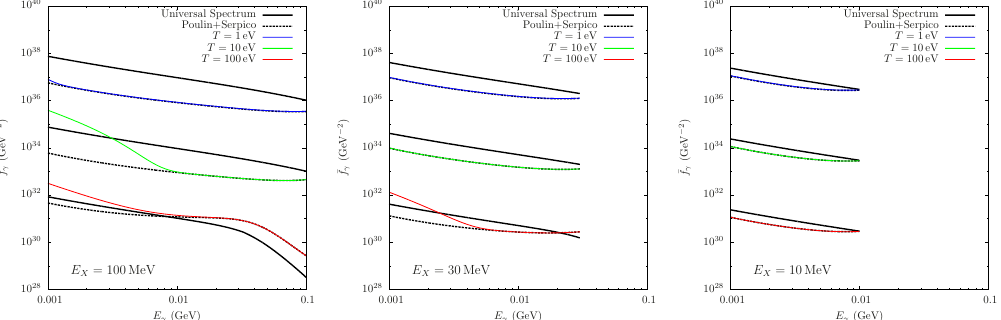
Figure 2 . Photon spectrum (cid:22) f (cid:13) ( E ) for photon injection with E X = 100 MeV (left), E X = 30 MeV (middle), and E X = 10 MeV (right), with T = 1 ; 10 ; 100 eV. Also shown are the predic- tions of the universal spectrum (solid) and the low-energy prescription of ref.